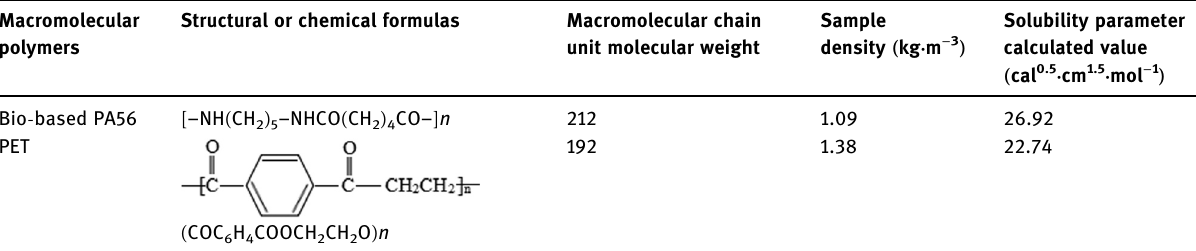
Table 3: Related parameters and solubility value of bio - based PA56/PET Macromolecular polymers